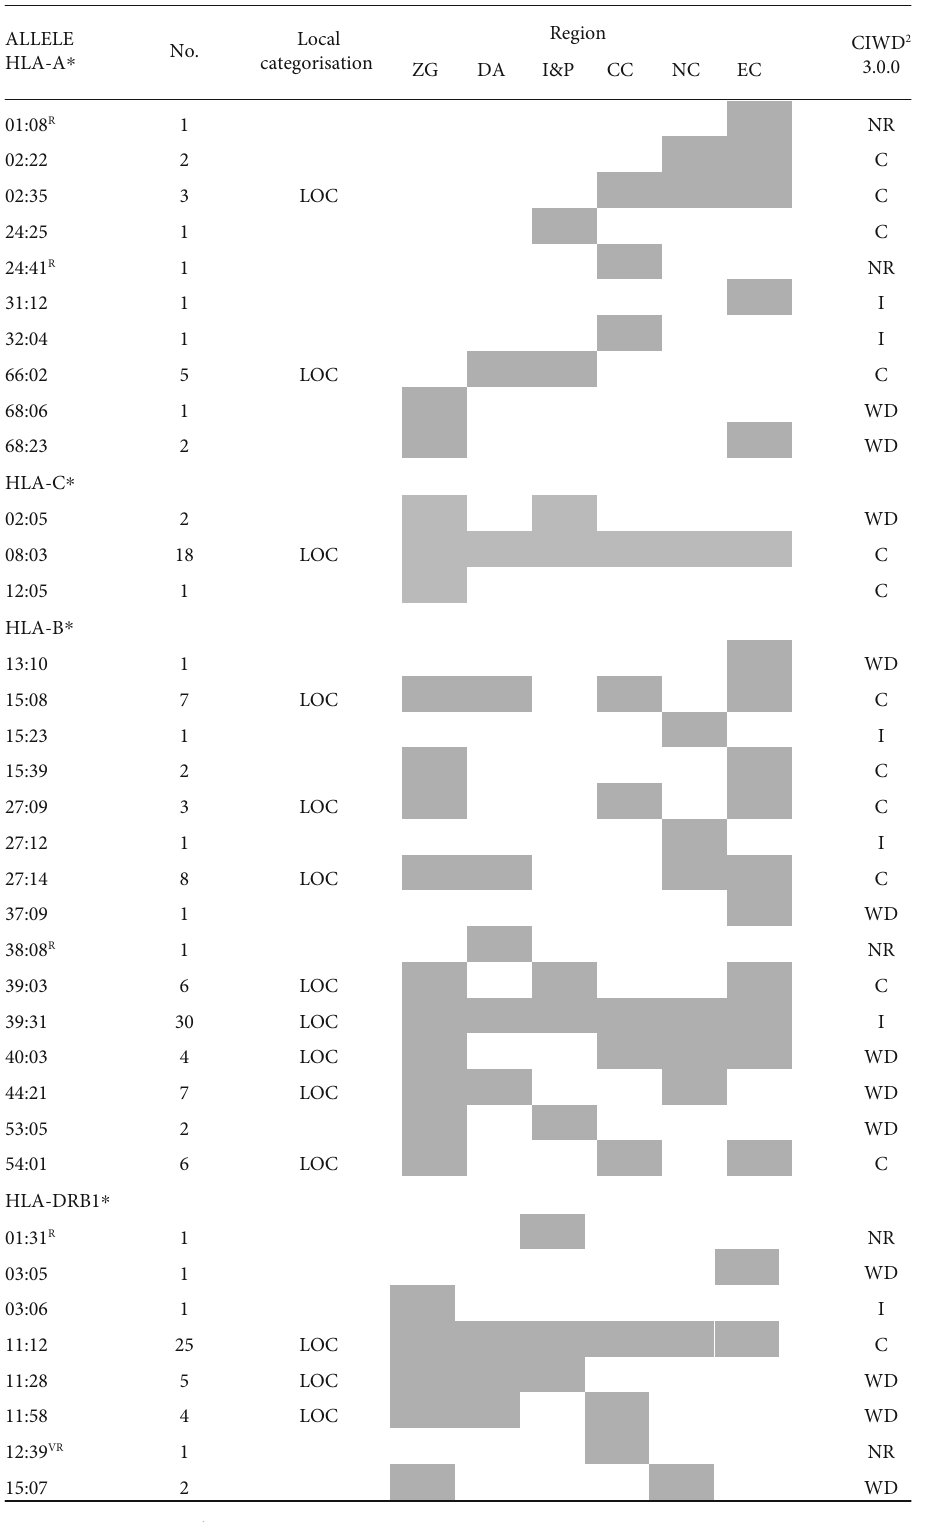
Figure 3: The distribution of non-CWD 1 alleles in di ff erent regions of Croatia. Legend: ZG: Zagreb; DA: Dalmatia; I&P: Istria & Primorje; CC: Central Croatia; EC: East Croatia; NC: North Croatia; No: number of occurrence in total sample; 1 common and well-documented alleles according to the EFI CWD catalogue [18]; R rare allele according to rare allele detector (RAD) [21]; VR very rare allele according to RAD 21 ; grey/white box: allele is present/absent in the region; LOC: alleles occurred ≥ 3 times in our sample but are not present in the EFI CWD catalogue [18]; grey-shaded box: allele observed; 2 reference [23]; C: common; I: intermediate; NR: not reported; WD: